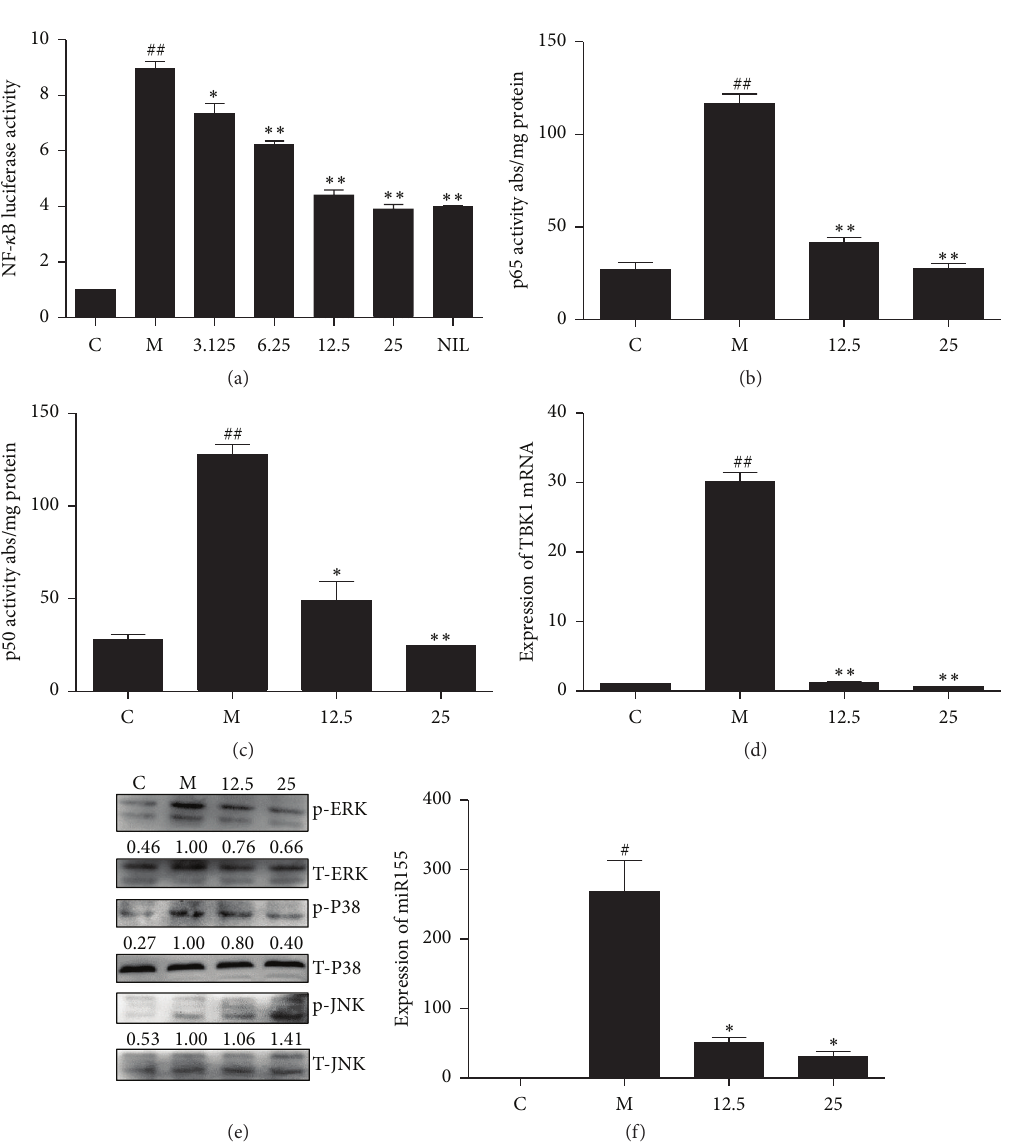
Figure 5: Effect of TIE on NF- 𝜅 B, MAPK activation, and miR155 expression in LPS/IFN 𝛾 -stimulated RAW264.7 cells. (a) RAW264.7 cells were transiently cotransfected with a pNF- 𝜅 B reporter vector. Cells were incubated with TIE (3.125, 6.25, 12.5, and 25 𝜇 M) and L-NIL (50 𝜇